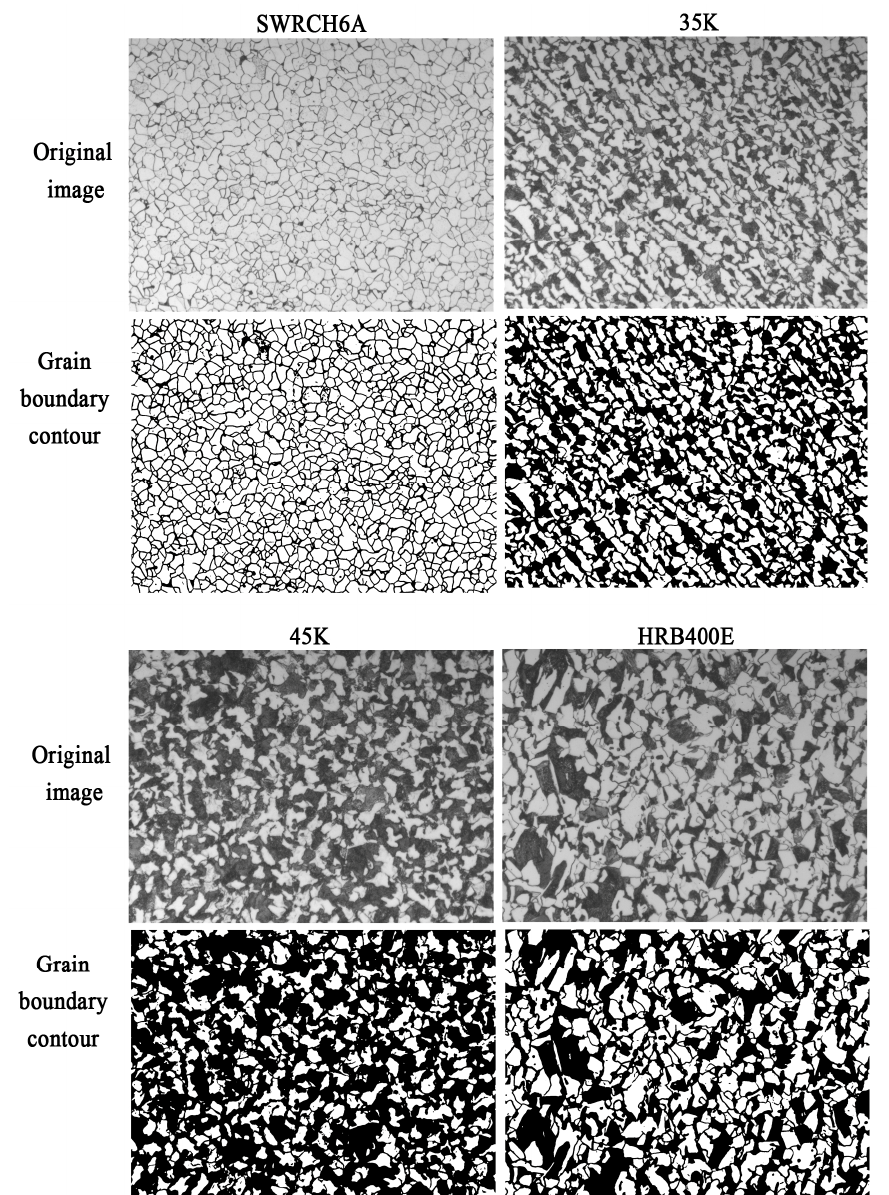
Figure 10. Grain-boundaries segmentation results. Figure 10. Grain‑boundaries segmentation